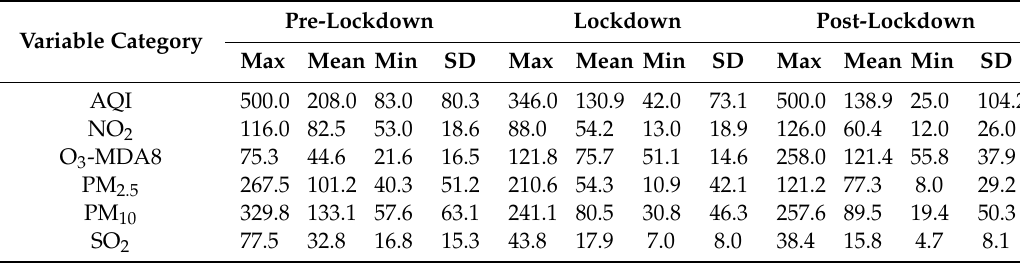
Table A1. Statistics of pollutants and meteorological parameters during the preset period (Specific parameters are defined in Table